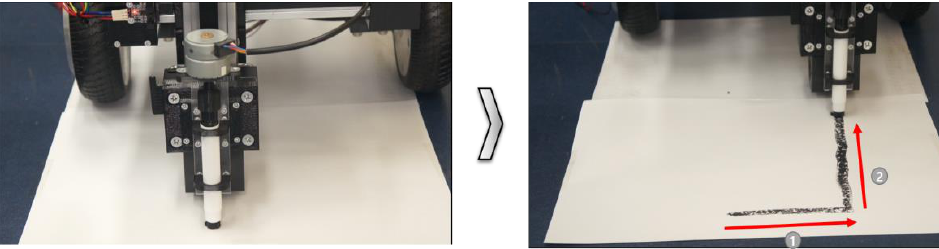
Figure 12. Before and after the x-axis movement marking functionality test.